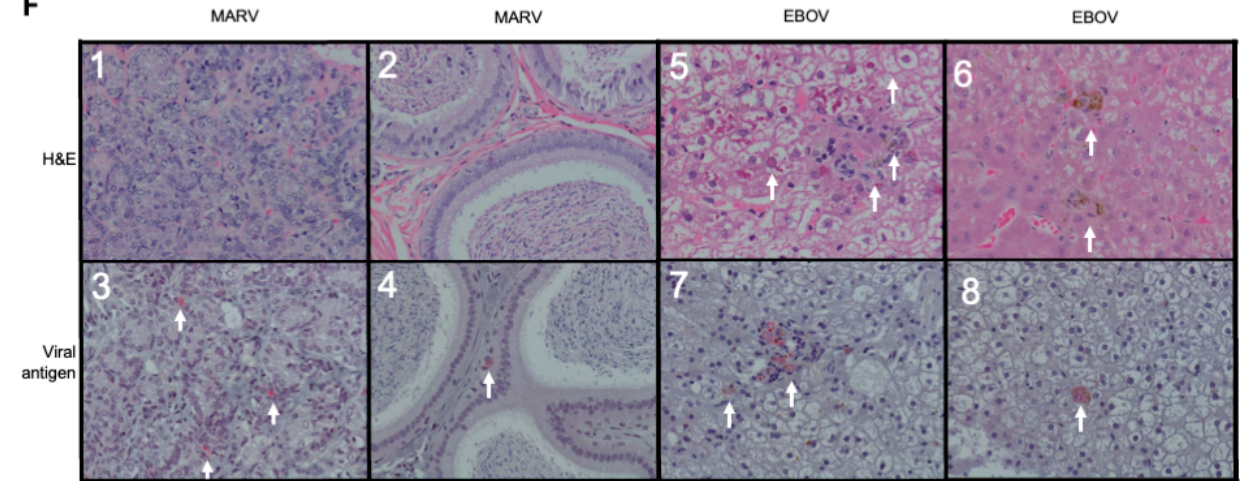
Figure 1. Infection of bats with filoviruses MARV and EBOV. ( A – C ). Time course after infection for weight ( A ), temperature ( B ), and viral RNA specific for the NP gene in total RNA extracted from whole blood ( C ). Animals were euthanized 48 h after first viremic time point. ND, not detected for EBOV (the MARV-infected bats were euthanized at this time point). ( D , E ). Tissue viral loads on day 7 for EBOV ( D ) and day 11 for MARV ( E ) determined by plaque assay. Note that transponders in MARV-infected bat 2 and EBOV-infected bat 1 on 11 dpi failed. ( F ). Histopathology and viral antigen in filovirus infected organs showing: ( F1 ) Lack of significant histopathological lesions in mammary tissue from MARV-infected bat 1, ( F2 ) Lack of significant histopathological lesions within the interstitium of the epididymis from MARV-infected bat 3, ( F3 ) IHC detection of MARV antigen within the interstitium of the glandular structures of the mammary gland from MARV-infected bat 1 (red pigment, arrows), ( F4 ) IHC detection of MARV antigen within the interstitium of the epididymis from MARV-infected bat 3 (red pigment, arrows), ( F5 ) EBOV-infected bat 1 liver with marked histopathological changes, including cytoplasmic and nuclear inclusions (arrows), ( F6 ) EBOV- infected bat 2 liver displaying a less dramatic presentation compared to bat 1 (arrows), ( F7 ) IHC detection of EBOV antigen in the liver of EBOV-infected bat 1 (arrows), ( F8 ) IHC detection of EBOV antigen in EBOV-infected bat 1 liver (an